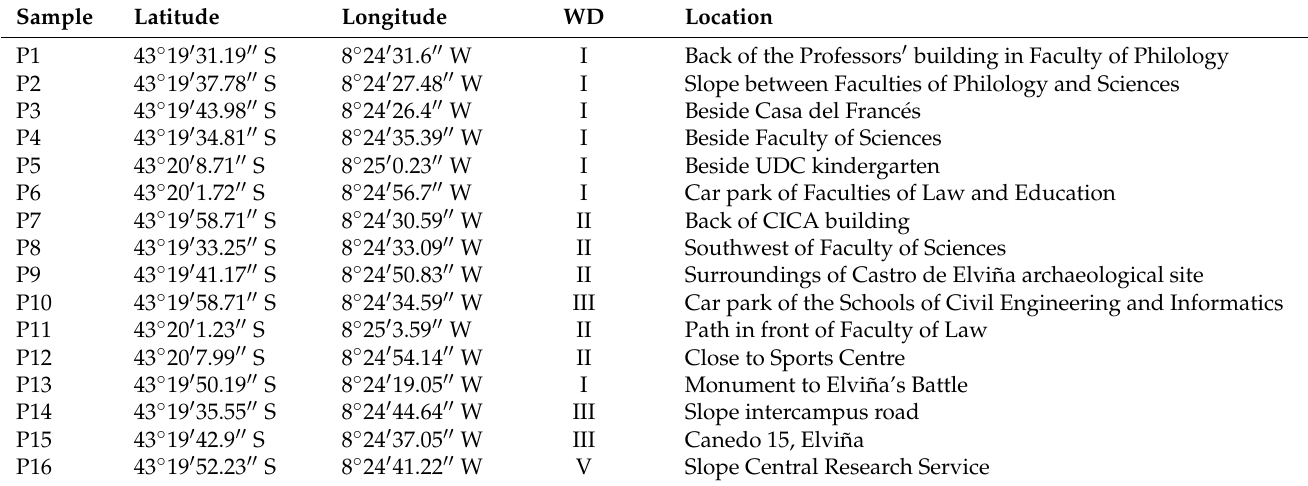
Table 1. Position and coordinates of the studied outcrops and samples